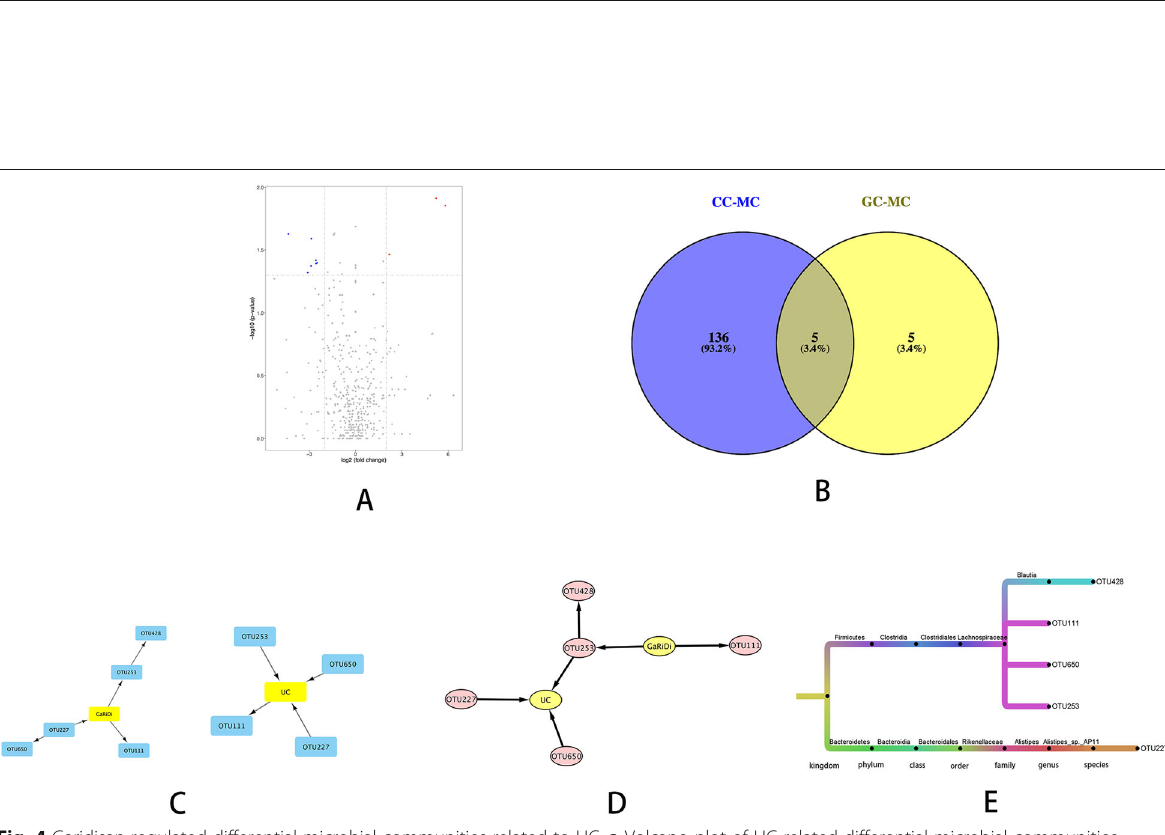
Fig. 4 Garidisan regulated differential microbial communities related to UC. a Volcano plot of UC-related differential microbial communities between the Garidisan group and model group; b Venn diagram of identical differential OTUs in the Garidisan group (left circle is the differential OUTs between the control group and model group; right circle is the differential OTUs between the Garidisan group and model group). c Bayesian network analysis of the causal relationship of differential OTUs of the luminal contents to Garidisan and UC (left plot is the Bayesian network analysis of the causal relationship of differential OTUs of luminal content to Garidisan; the right plot is the Bayesian network analysis of the causal relationship of differential OTUs of luminal contents to UC); d Network diagram of mutual interactions between Garidisan, OUTs, and UC; e Species annotation of OTU428, OTU111, OTU650, OTU253, and